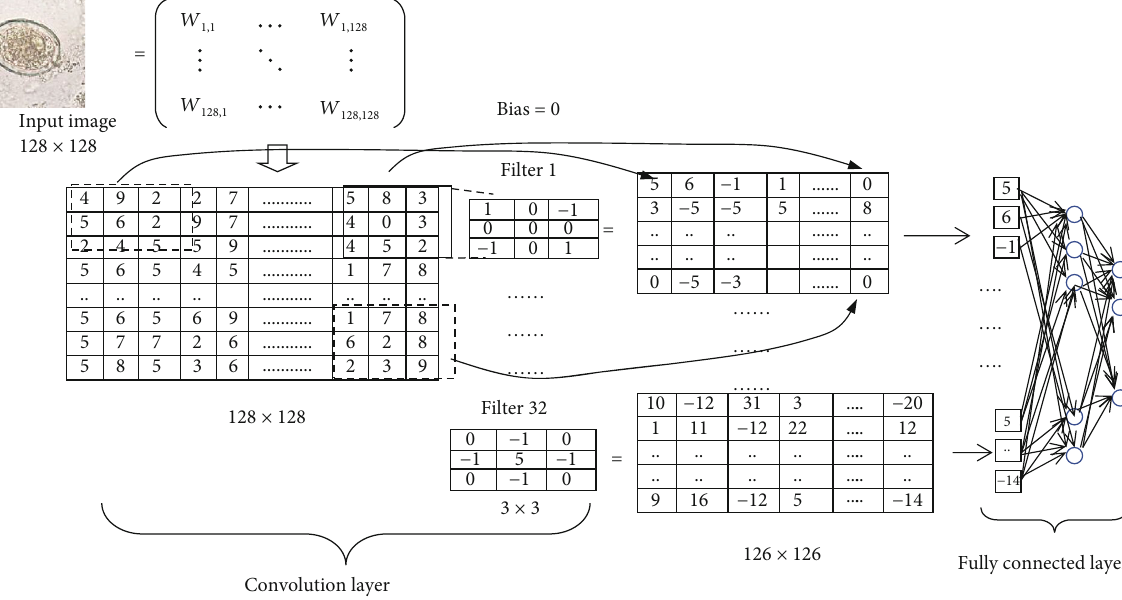
Figure 6: Example shape calculator for convolutional